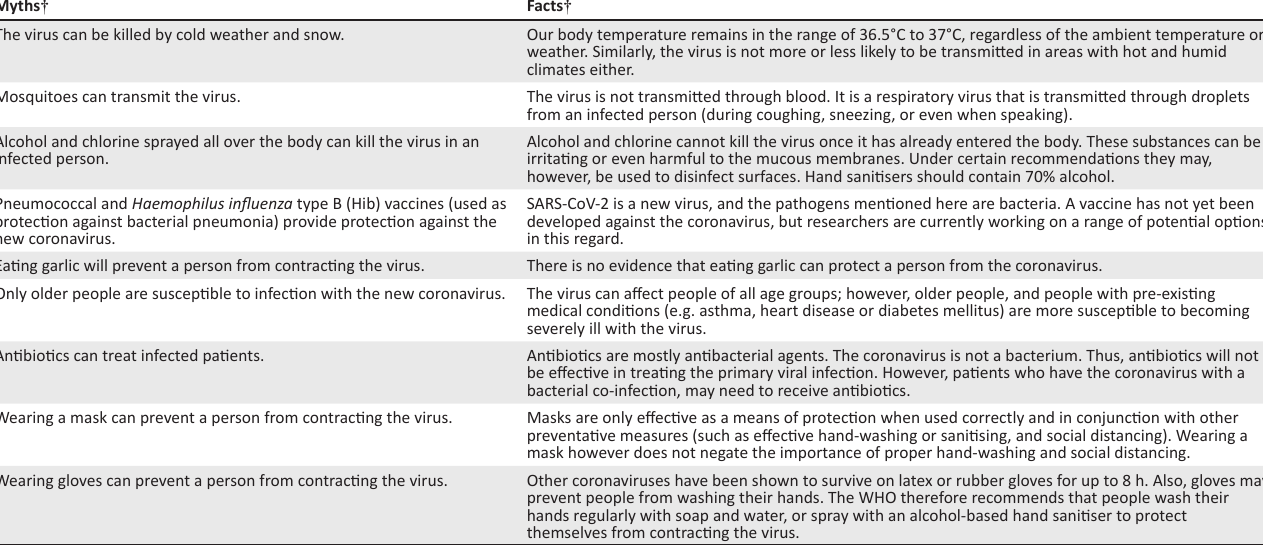
TABLE 1: Examples of myths that are appearing viral on social media and the facts that may assist in countering them (based on information provided by the World Health Organization). 10 Myths †